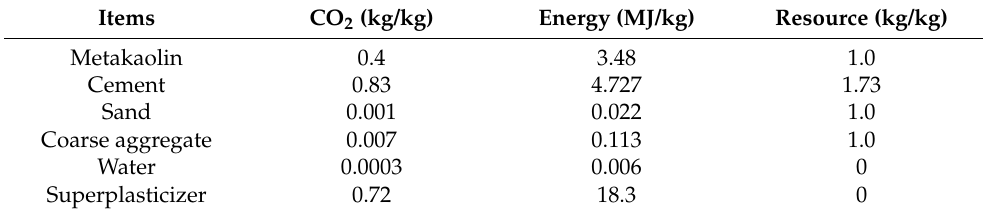
Table 2. The CO 2 emissions, energy consumption, and resource consumption of concrete components. Adapted with permission from ref. [15]. Copyright 2015